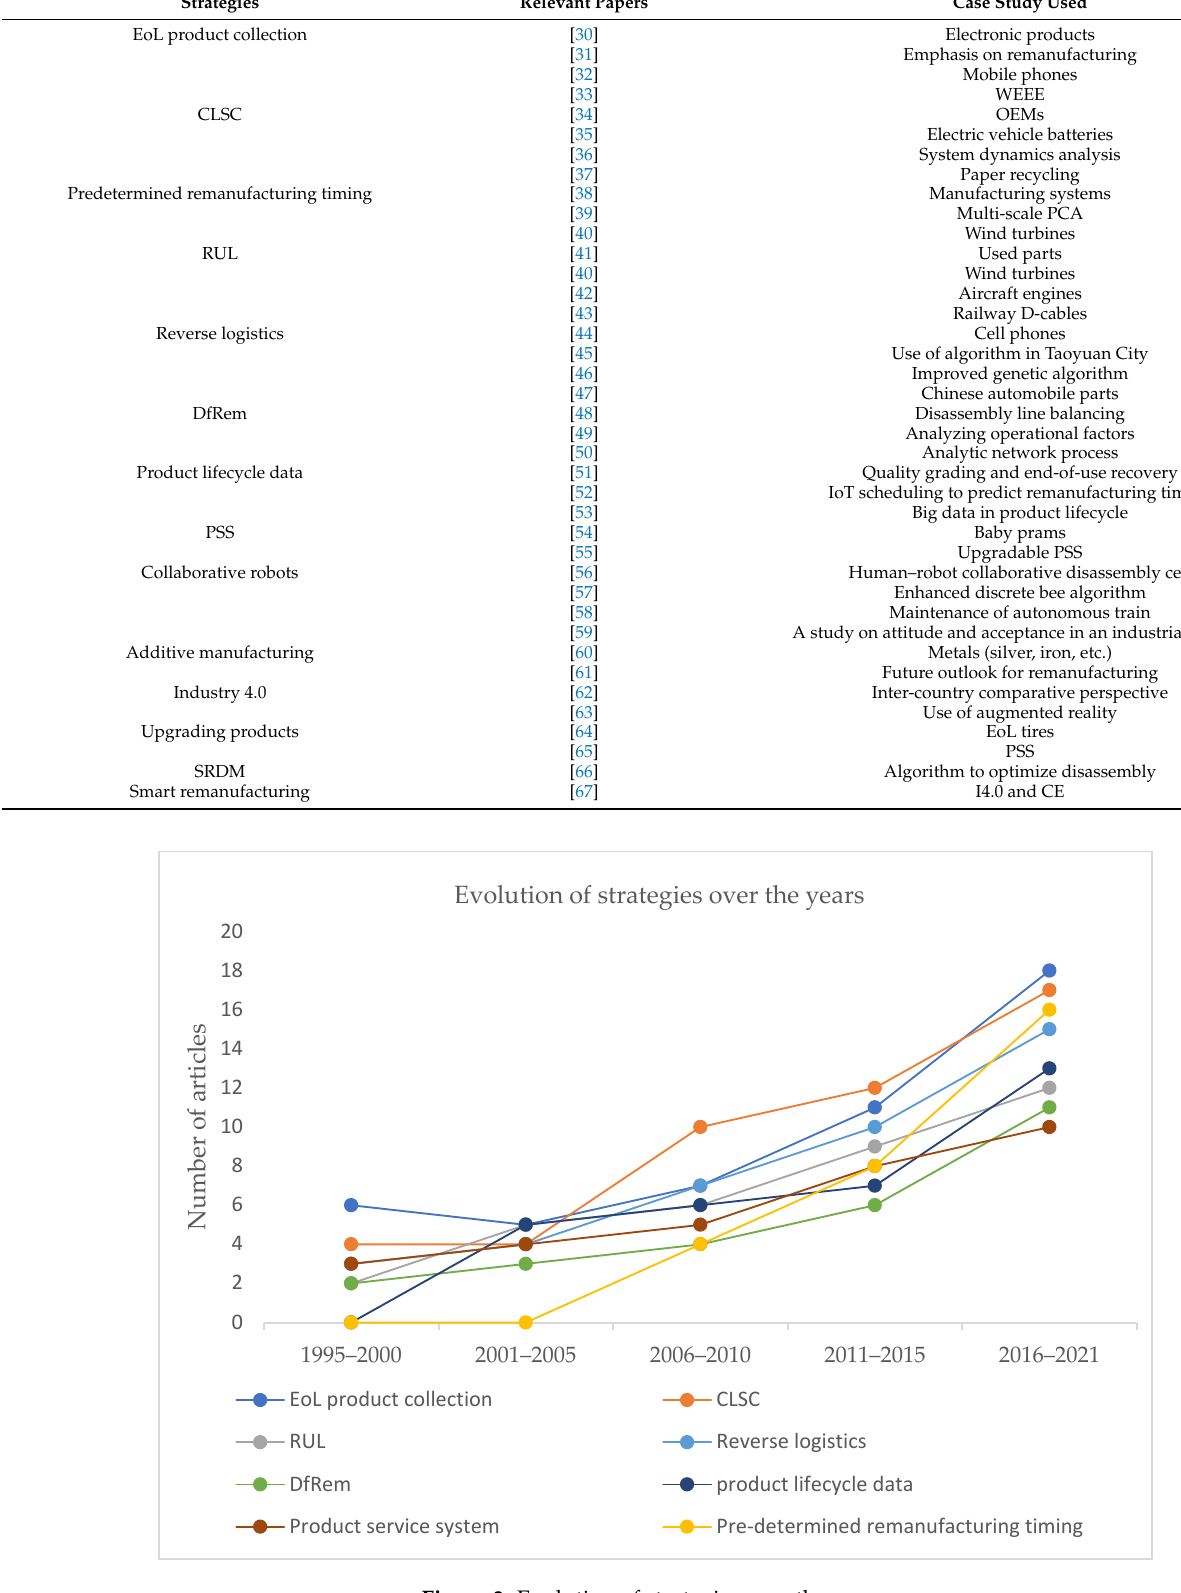
Figure 3. Evolution of strategies over the years .